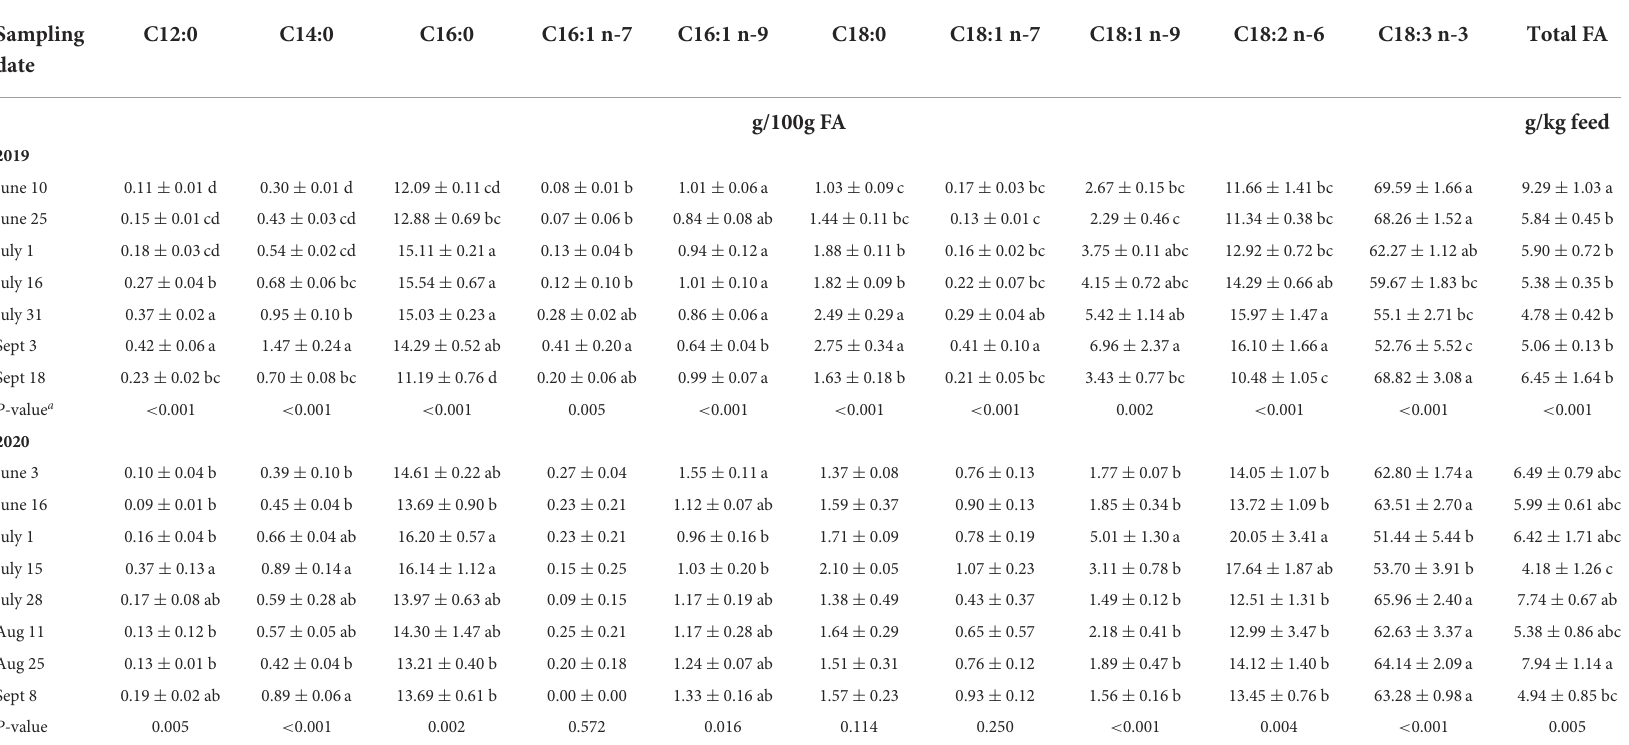
TABLE 4 Fatty acid profile of pasture by sampling